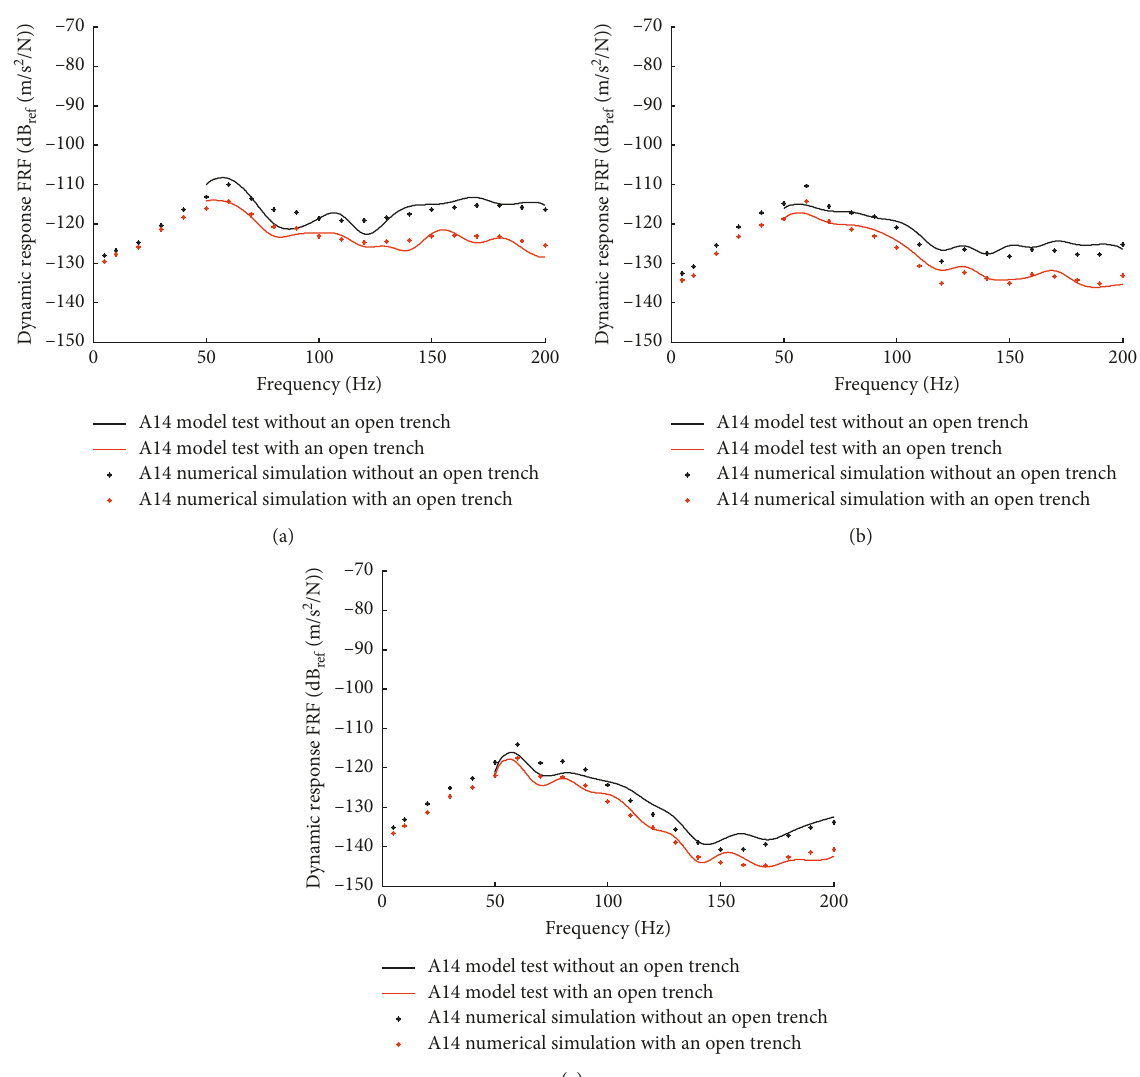
Figure 8: Vertical dynamic response of surface measuring points beyond the trench. (a) Testing point A14. (b) Testing point A16. (c) Testing point